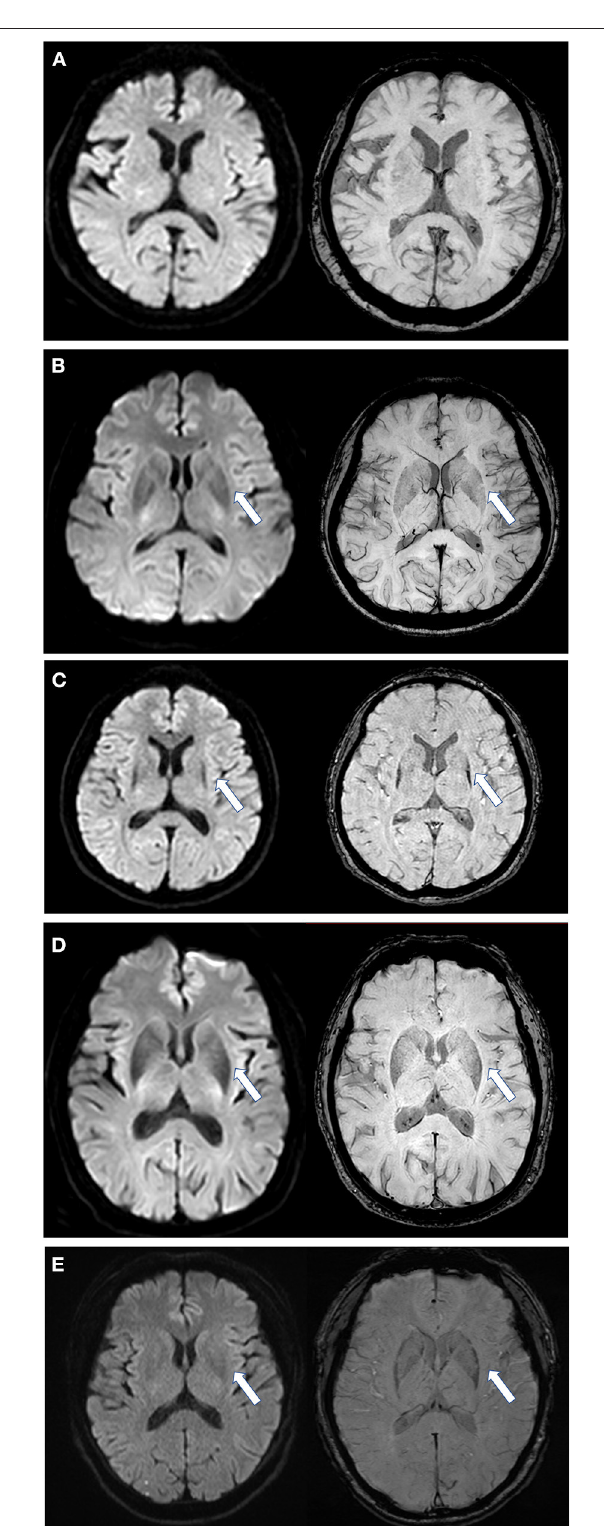
FIGURE 1 | Scores of putaminal hypointensity in DWI and the corresponding SWI sequence. Left, DWI sequence; right, SWI sequence. (A) DWI and SWI